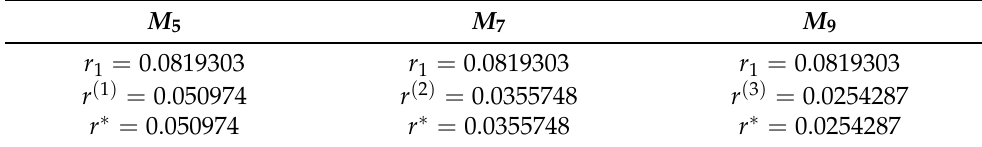
Table 3. Numerical results for example 3.